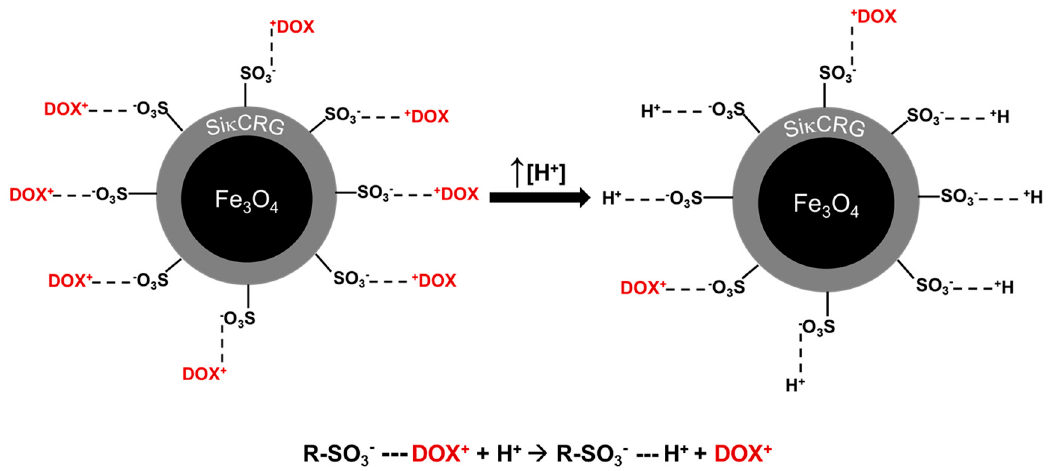
Figure 7. Schematic representation of the proposed cation exchange mechanism behind DOX release from the nanocarriers in acidic conditions, with the equation showing the equilibrium shift.